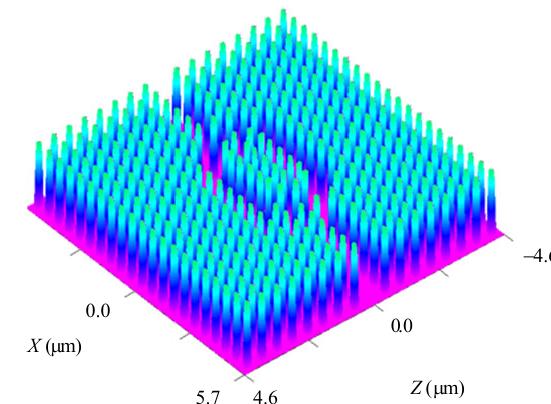
Fig. 3 3D structure of